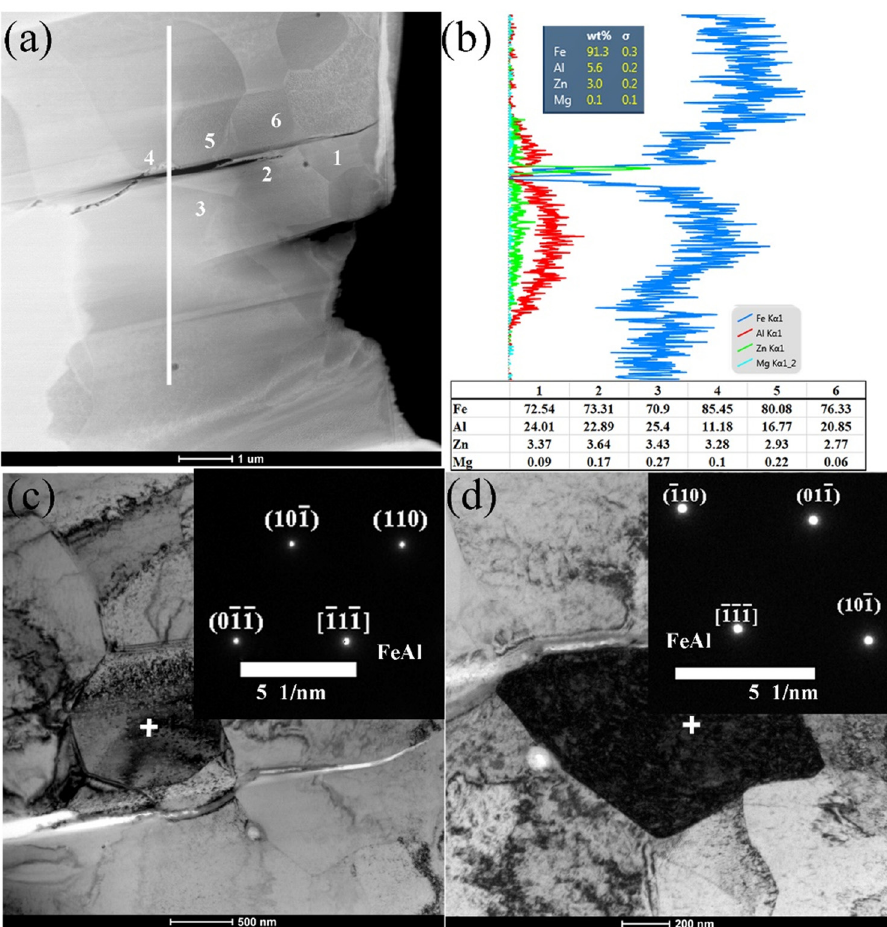
Figure 9: TEM images of HAZ - 1: ( a ) microstructural morphology of HAZ - 1; ( b ) line scanning; ( c ) and ( d ) SAED of unintegrated